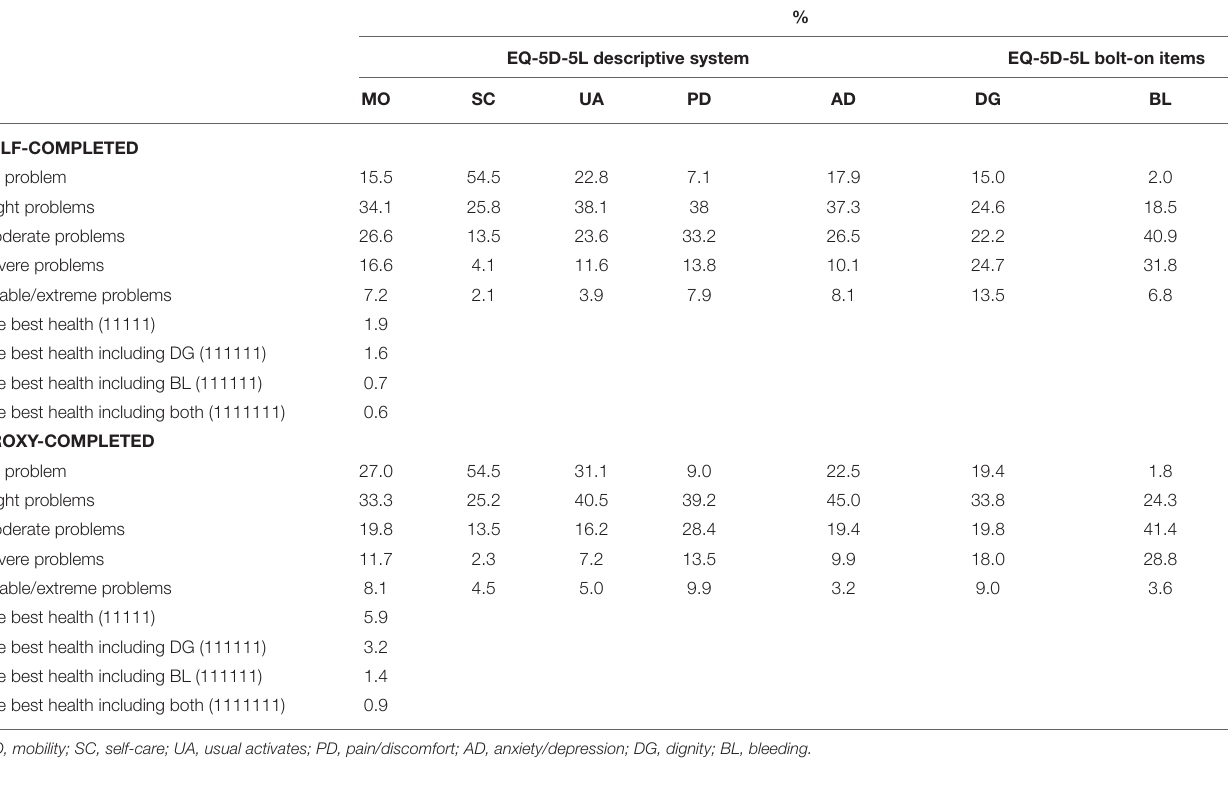
self- and proxy-completed samples) and significantly increased the discriminative power to differentiate patients with different health statuses. As expected, the DG item strongly